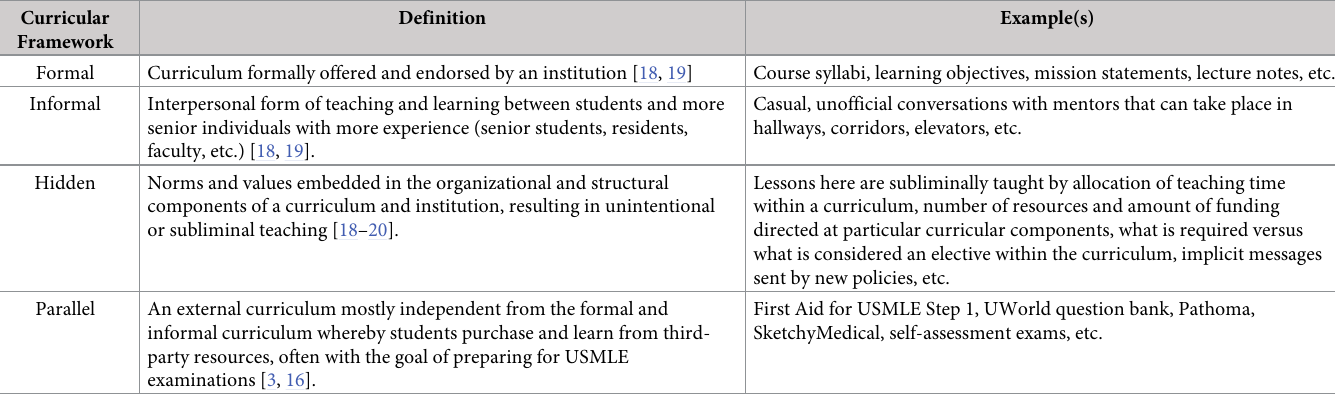
Table 1. Curricular frameworks found within undergraduate medical